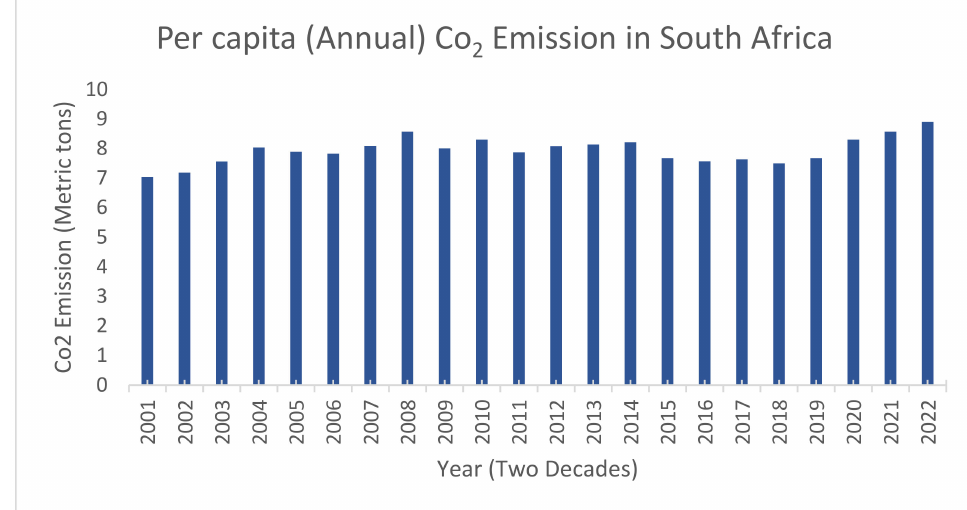
Figure 1. Per capita CO 2 emission in South